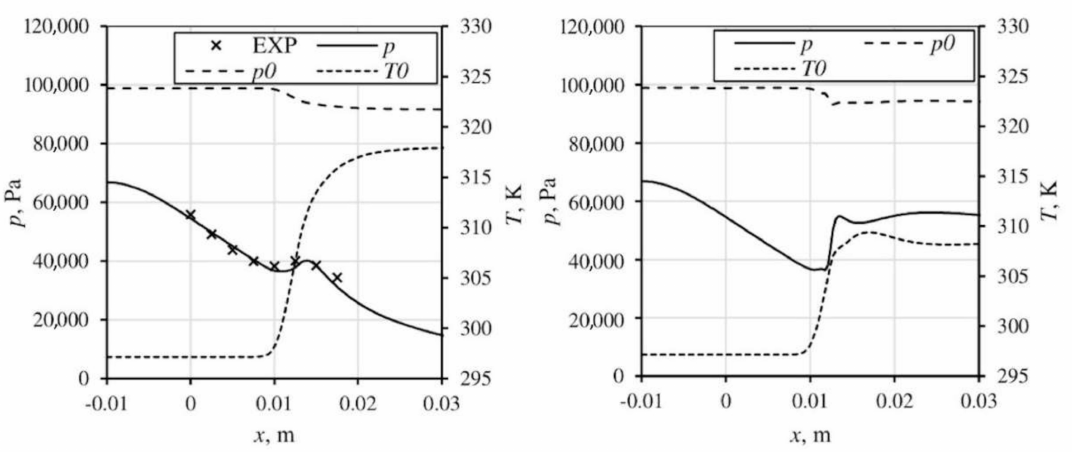
Figure 2. The experimental and numerical results for relative humidity equal to 43% (supersonic outlet—left, back pressure 55